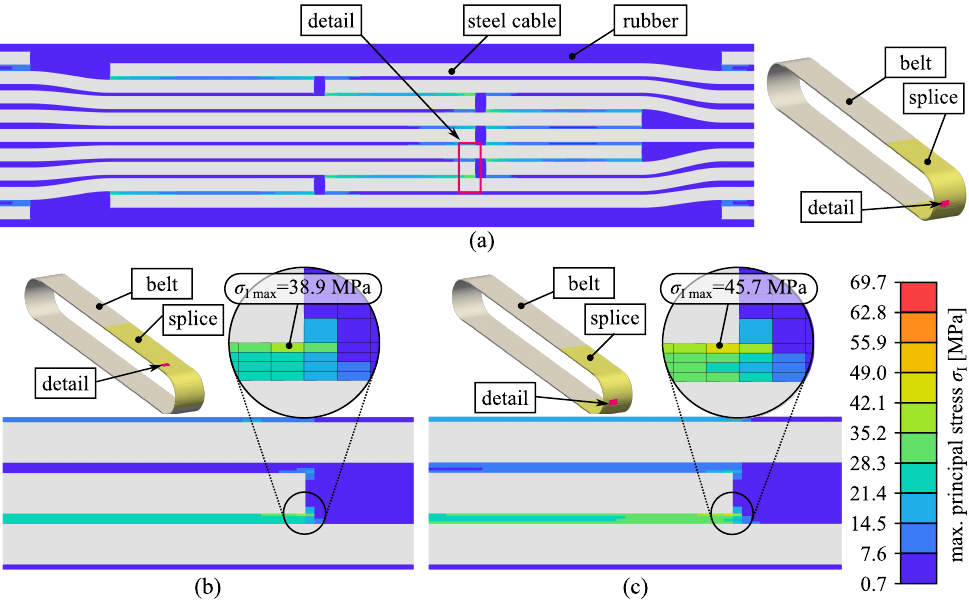
Figure 10. Stress results of the splice determined in the global model: ( a ) Top view of the splice with a general view where the splice location is shown, ( b ) detail of the splice for straight condition, and ( c ) detail for the splice for bent condition.